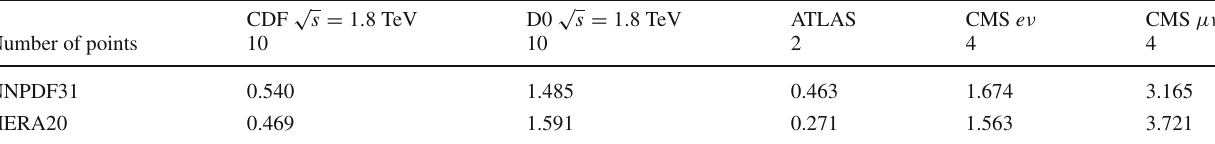
Table 2 χ 2 / N using the extraction of TMD of [35] and theoretical errors (which include scale variation and PDF error coming from 1000 replicas)